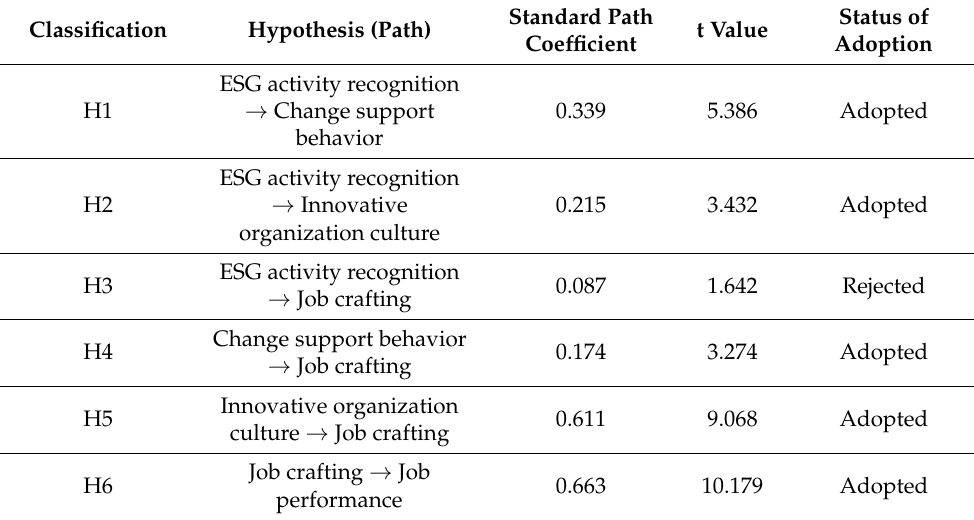
Table 6. Results of a hypothesis test.